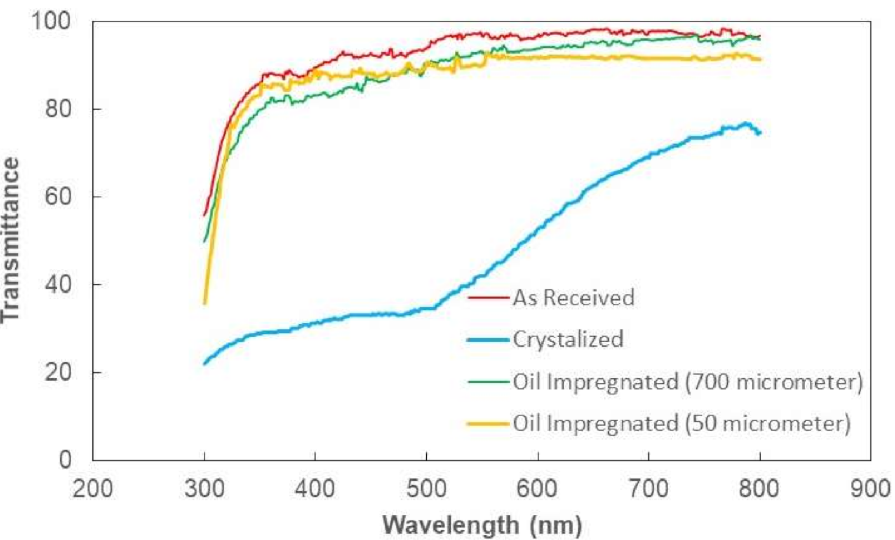
Figure 3. Optical transmittance of untreated, crystallized, and crystallized-oil impregnated polycar- bonate. Spherules and fibrils on the crystallized surface cause diffuse reflection and partial absorption of incident UV visible radiation while lowering specular transmittance (wavelength-dependent trans- mittance). The increasing wavelength of incident optical radiation lowers diffuse reflection and absorption from the crystallized surface.